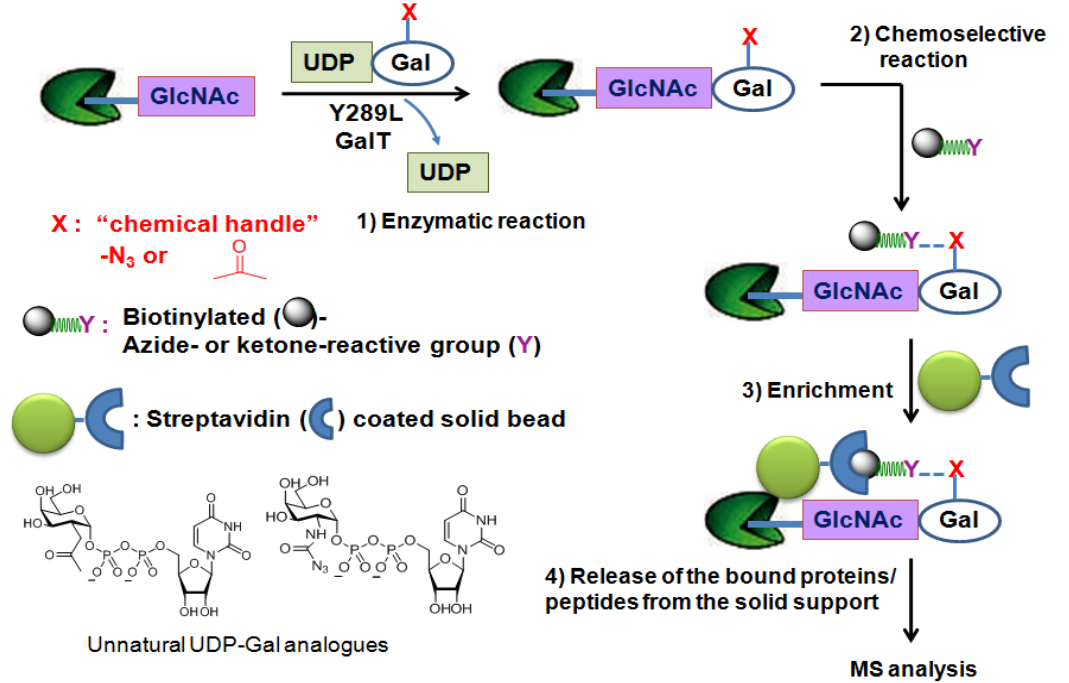
Figure 4. Chemoenzymatic tagging of O -GlcNAc-based enrichment